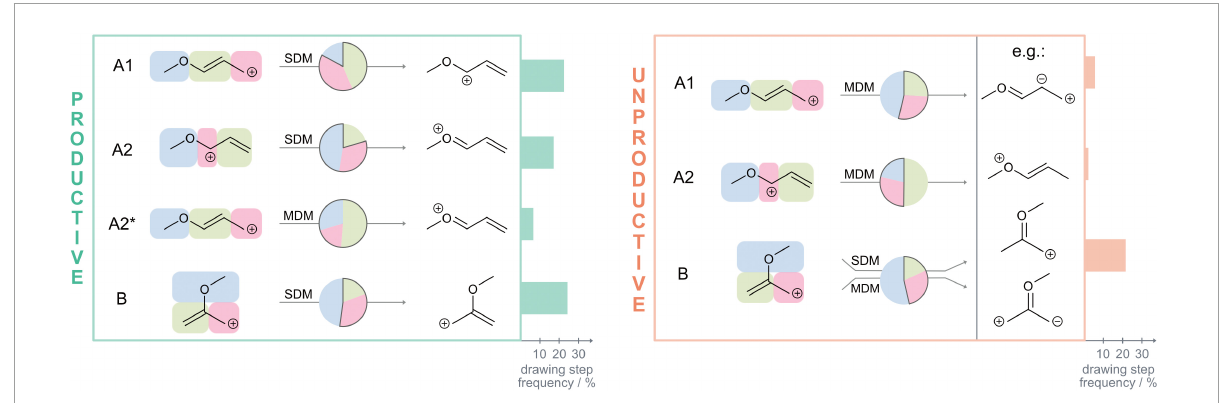
FIGURE8 Relative drawing step frequency ( N = 57) and fixation duration rates (pie charts) on the structural features of the initial structures (blue = methoxy group, green = double bond, pink = positive charge) when constructing a subsequent productive (green frame) or unproductive (orange frame) structure. The relevant, necessary structural features for the construction of the following structure are highlighted by framing. Drawing moves are indicated as single drawing move (SDM) and multiple drawing moves